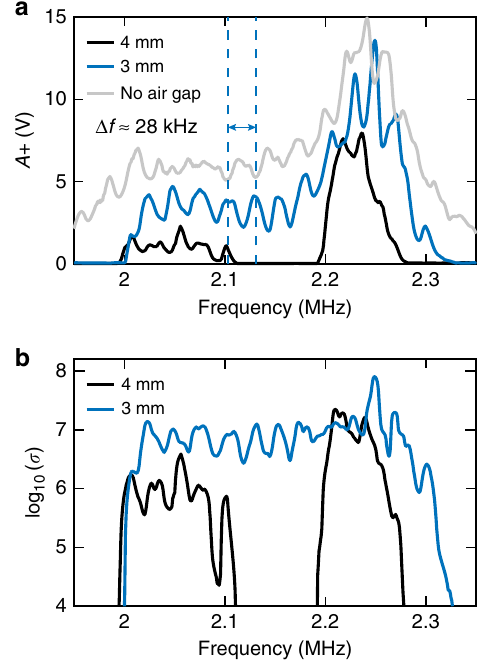
Fig. 3 Experimental frequency response of the diode effect: a Transmitted amplitude in the forward direction ( A + ) vs. excitation frequency for the diode system with two different air-gap thicknesses, as well as for the reference case without an air gap. The excitation amplitude is V in = 500 V. b Transmission asymmetry ratio σ = A + 2 / A − 2 vs. frequency for two distinct air-gap